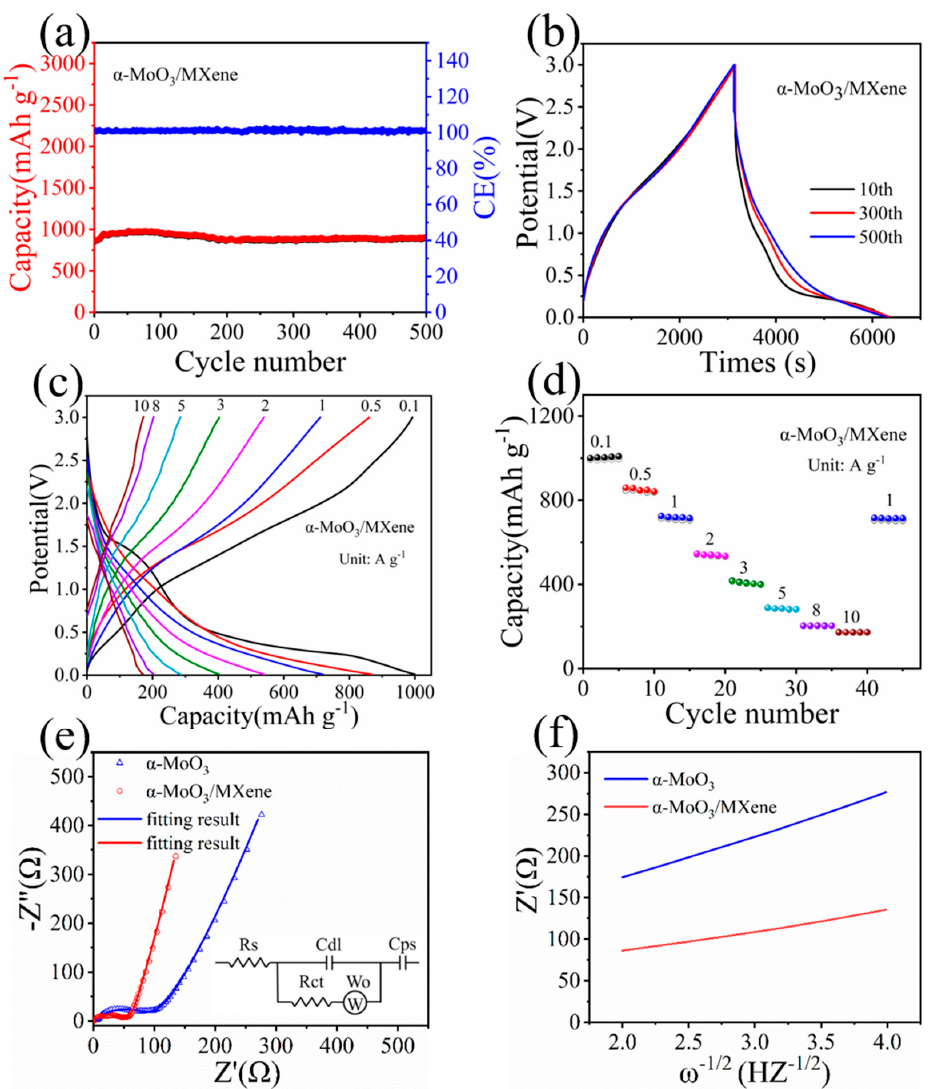
Figure 3. ( a ) Cycling performance of α− MoO 3 /MXene at 0.5 A g − 1 . ( b ) GCD curves of α− MoO 3 /MXene in different cycles at 0.5 A g − 1 . ( c ) GCD curves and ( d ) rate capability of α− MoO 3 /MXene. ( e ) Nyquist plots of α− MoO 3 and α− MoO 3 /MXene (inset of electrical equivalent circuit). ( f ) The relationship between Z ′ and ω − 1/2 ( ω = 2 π f) in the low − frequency region of α− MoO 3 and α− MoO 3 /MXene.